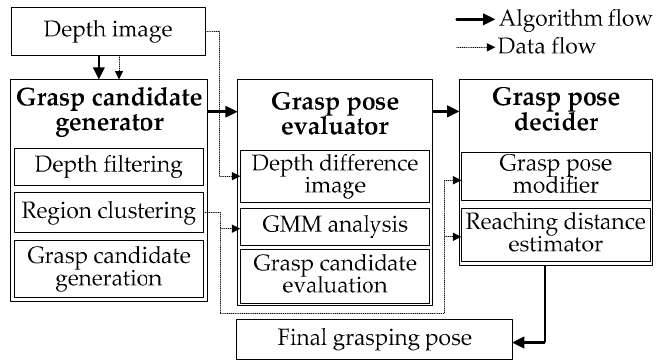
Figure 1. Structure of DBP (DDI-based bin picking).